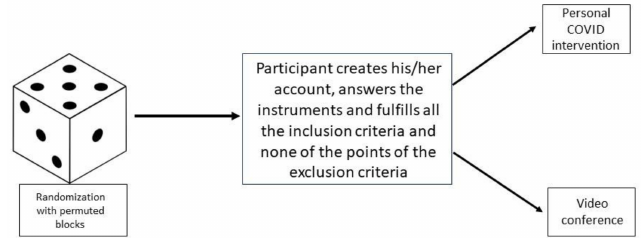
Figure 2. Randomization